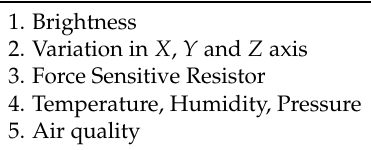
Table 7. Parameters for which data are